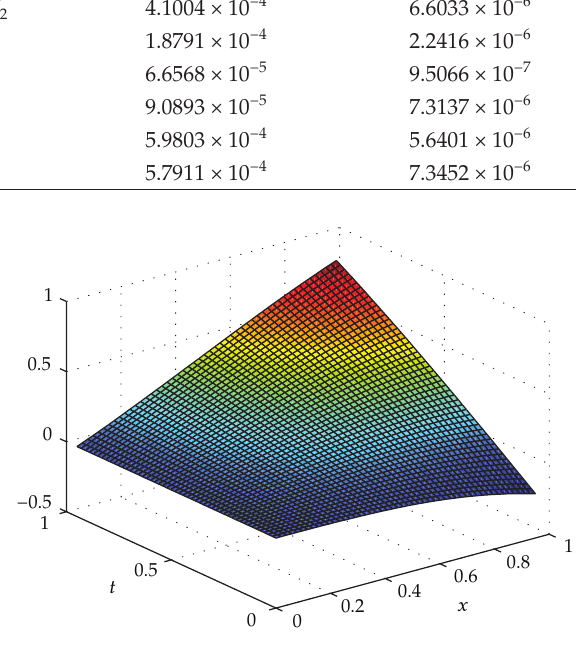
Figure 1: LPR of Example